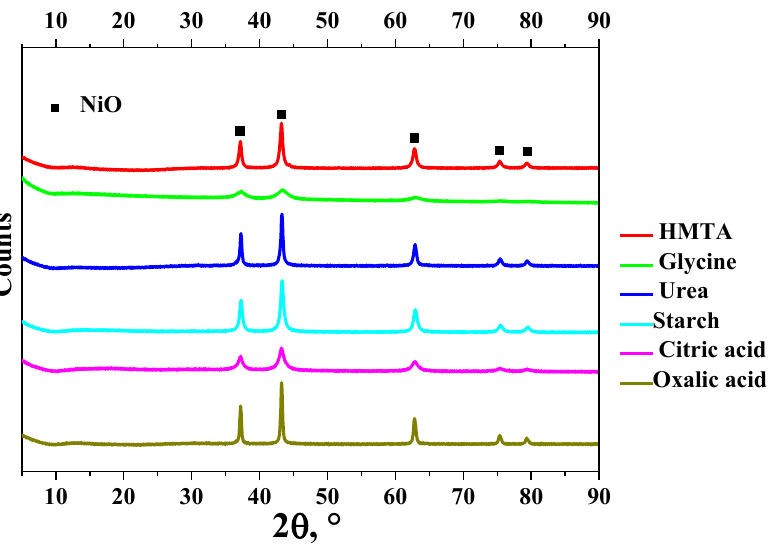
Figure 4. XRD patterns of catalysts synthesized.